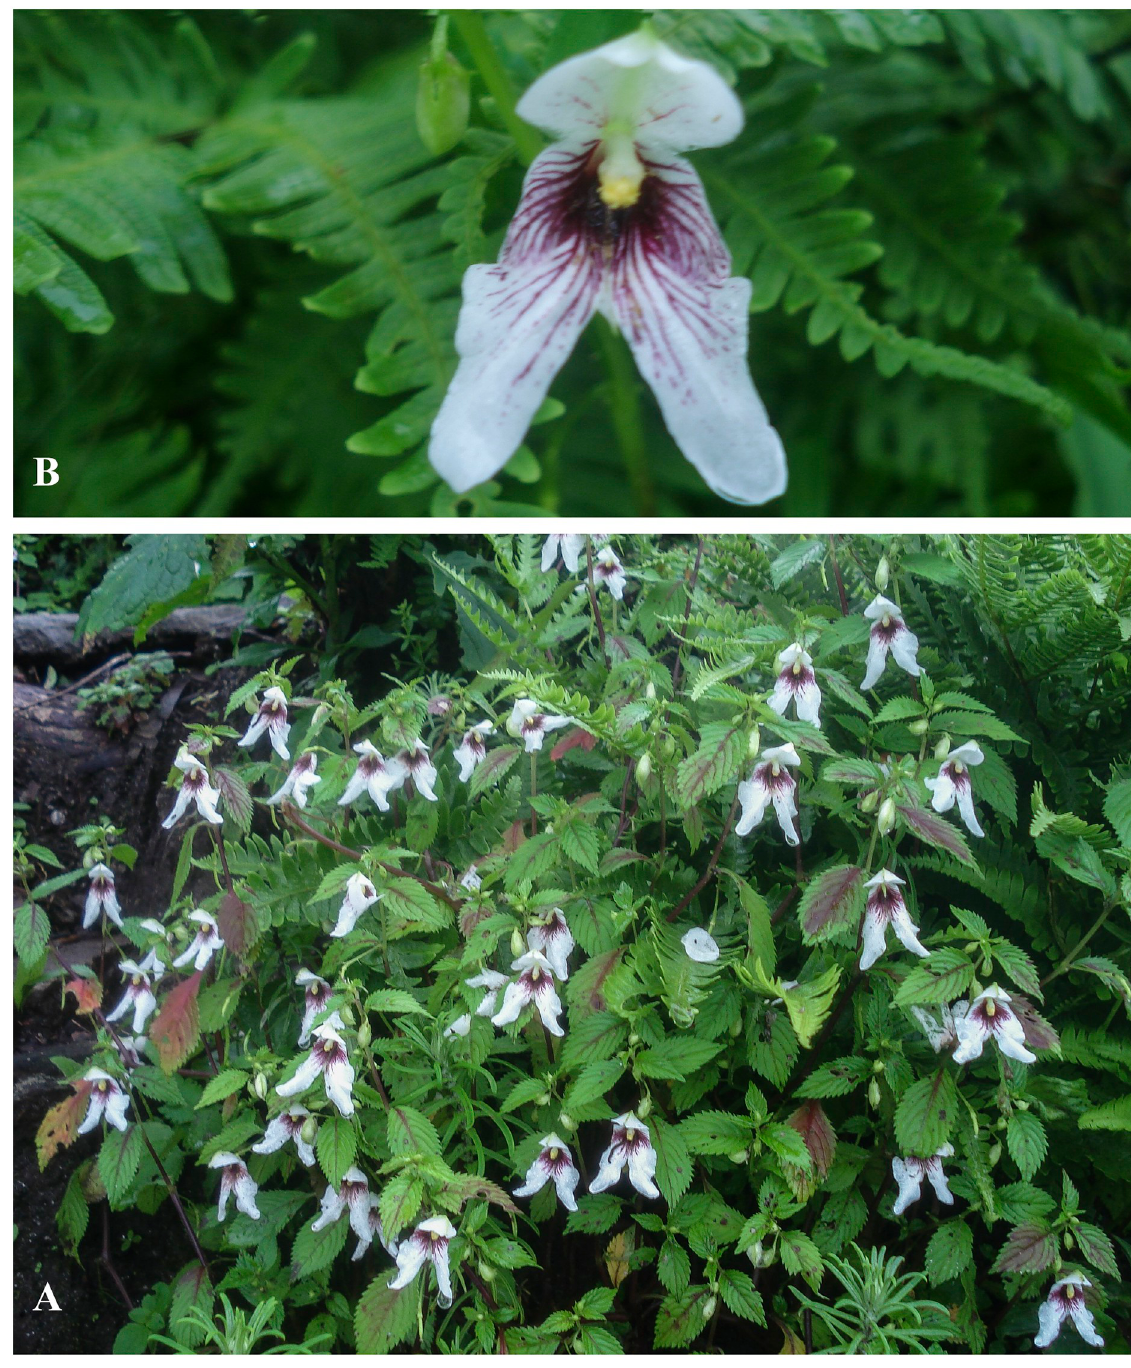
Fig 25. Impatiens serrata A. Flowering plant; B. Flower (Front view). Photographs by Bhakta Bahadur Raskoti.